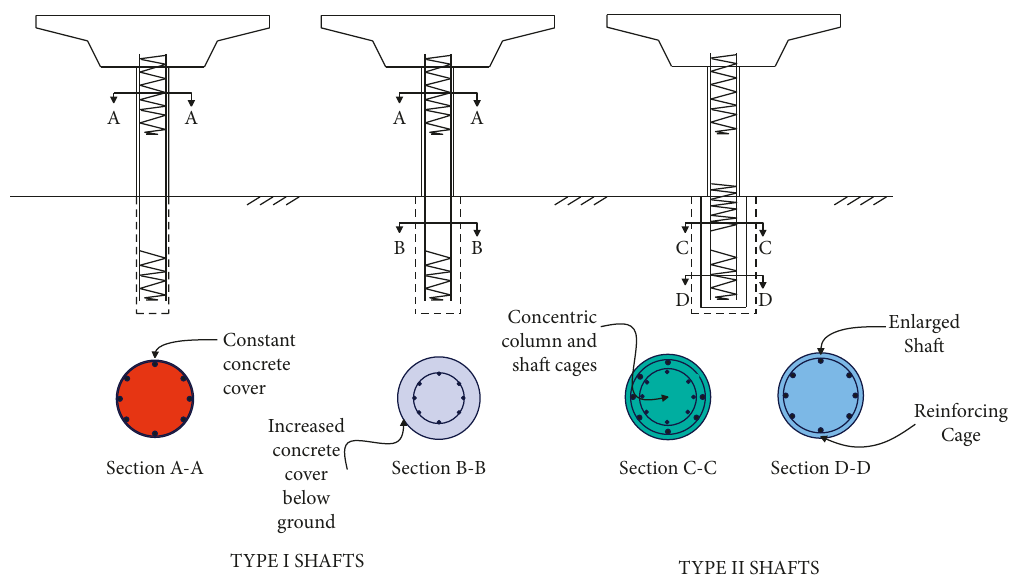
Figure 1: Main forms of bridge piers in the Caltrans specification in the United